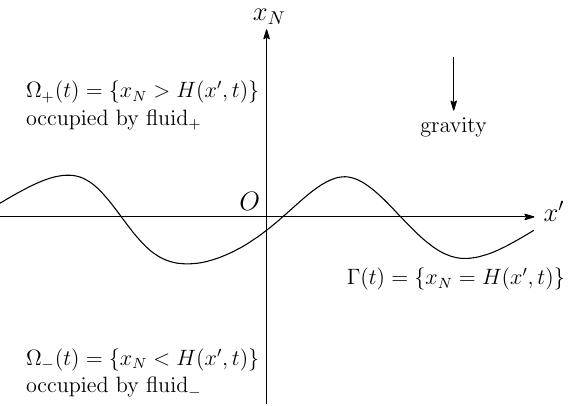
Figure 1. The domains Ω